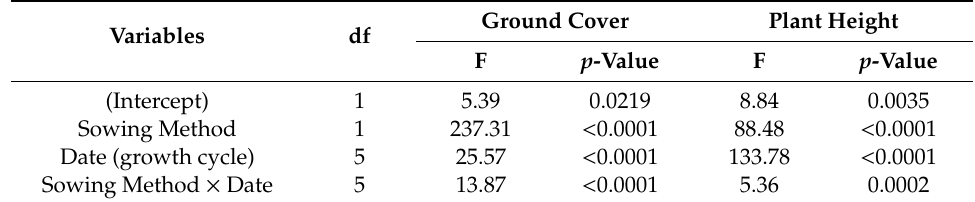
Table 2. Fixed e ff ects (F) of the explanatory variables on ground cover and height of A. arvensis ; df refers to degree of freedom of the numerator; df of denominator = 125 (Fisher’s LSD test). Ground Cover Plant Height Variables df F p